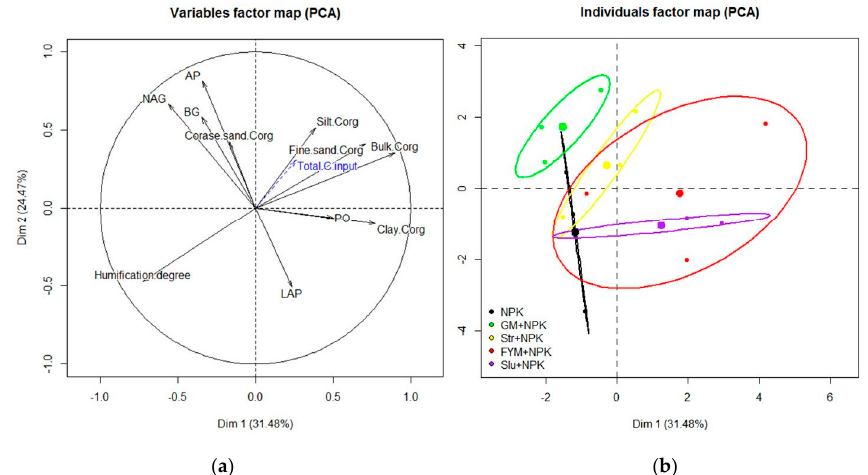
Figure 5. Soil enzyme activity of ( a ) β -glucosidase (BG), ( b ) β -1,4- N -acetylglucosaminidase (NAG), ( c ) phosphatase (AP), ( d ) leucine aminopeptidase (LAP), and ( e ) phenol oxidase (PO). Different letters indicate significant differences between treatments ( p < 0.05; n = 3). The centerline represents the median, the dot represents the mean, the lower and the upper lines of the boxplot represent the 25th and the 75th percentiles, and the box whiskers represent minimum and maximum values. NPK : mineral fertilization alone; GM + NPK : green manure + mineral fertilization; Str + NPK : cereal straw + mineral fertilization; FYM + NPK : farmyard manure + mineral fertilization; Slu + NPK : cattle slurry + mineral fertilization.